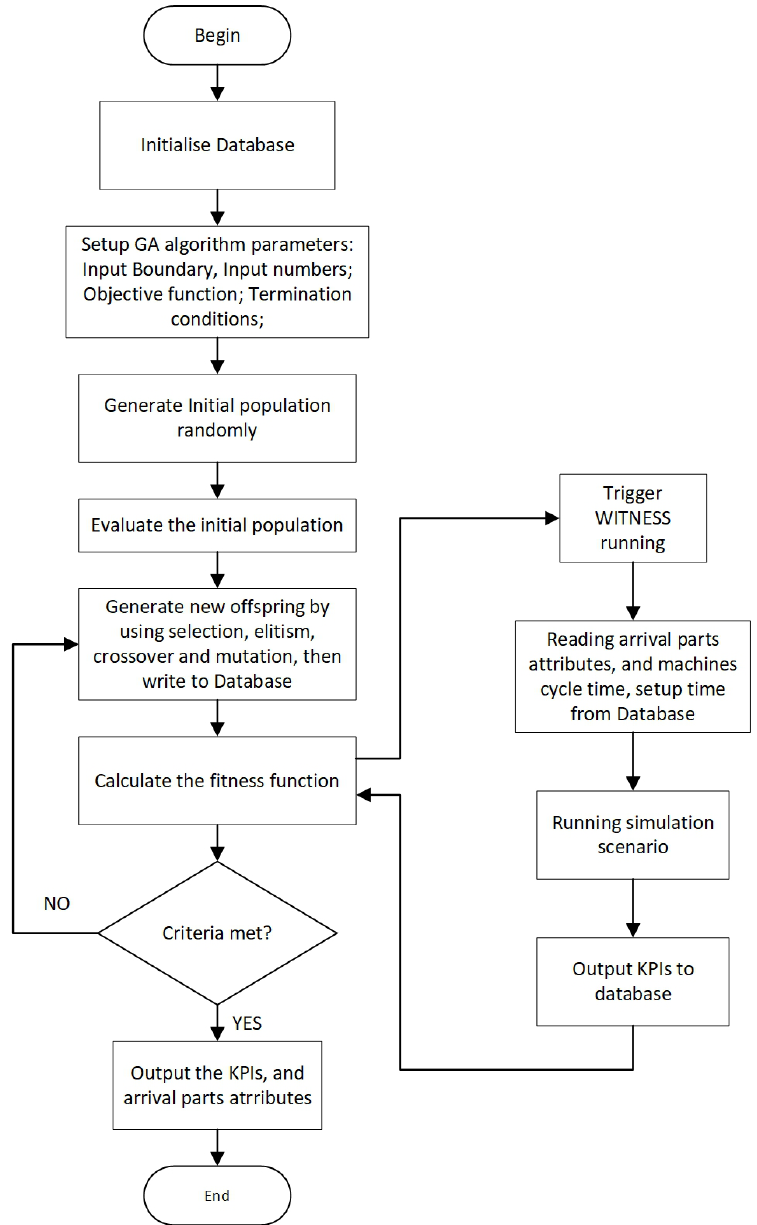
Figure 6. The flow-chart of the